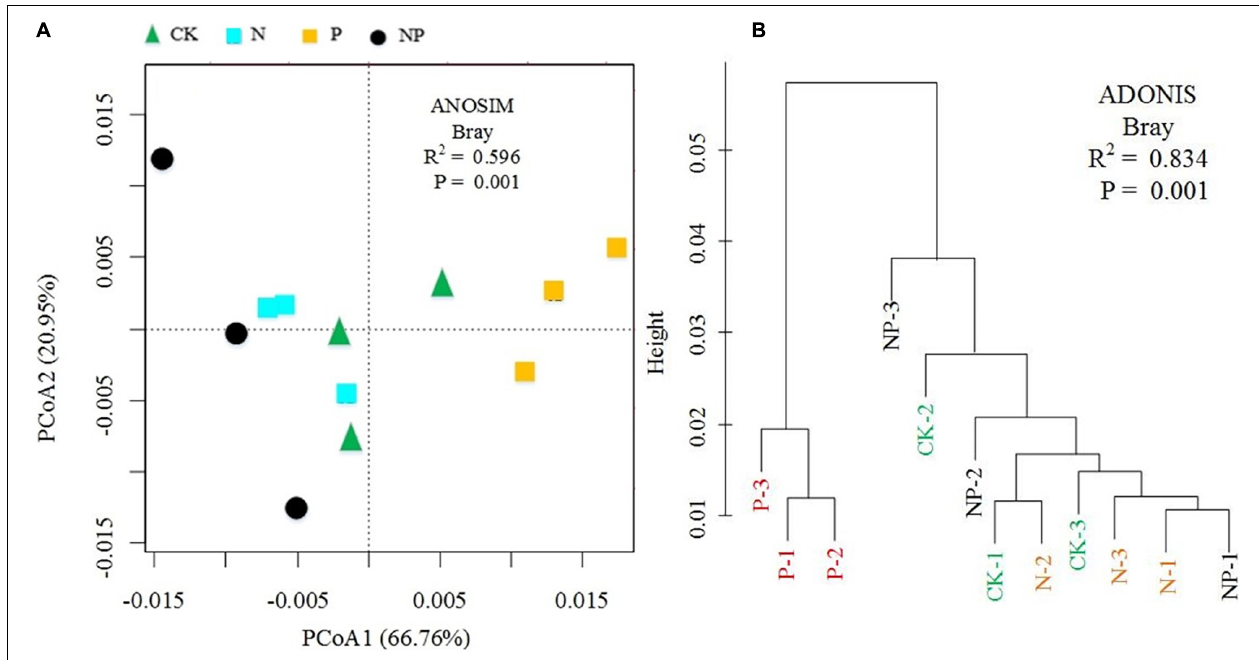
FIGURE 5 | (A) Principal coordinates analysis (PCoA) and (B) cluster analysis of microbial functional gene composition (CK = control, N = addition of 72 kg N hm − 2 year − 1 , P = addition of 36 kg P hm − 2 year − 1 , NP = interaction of N and P).